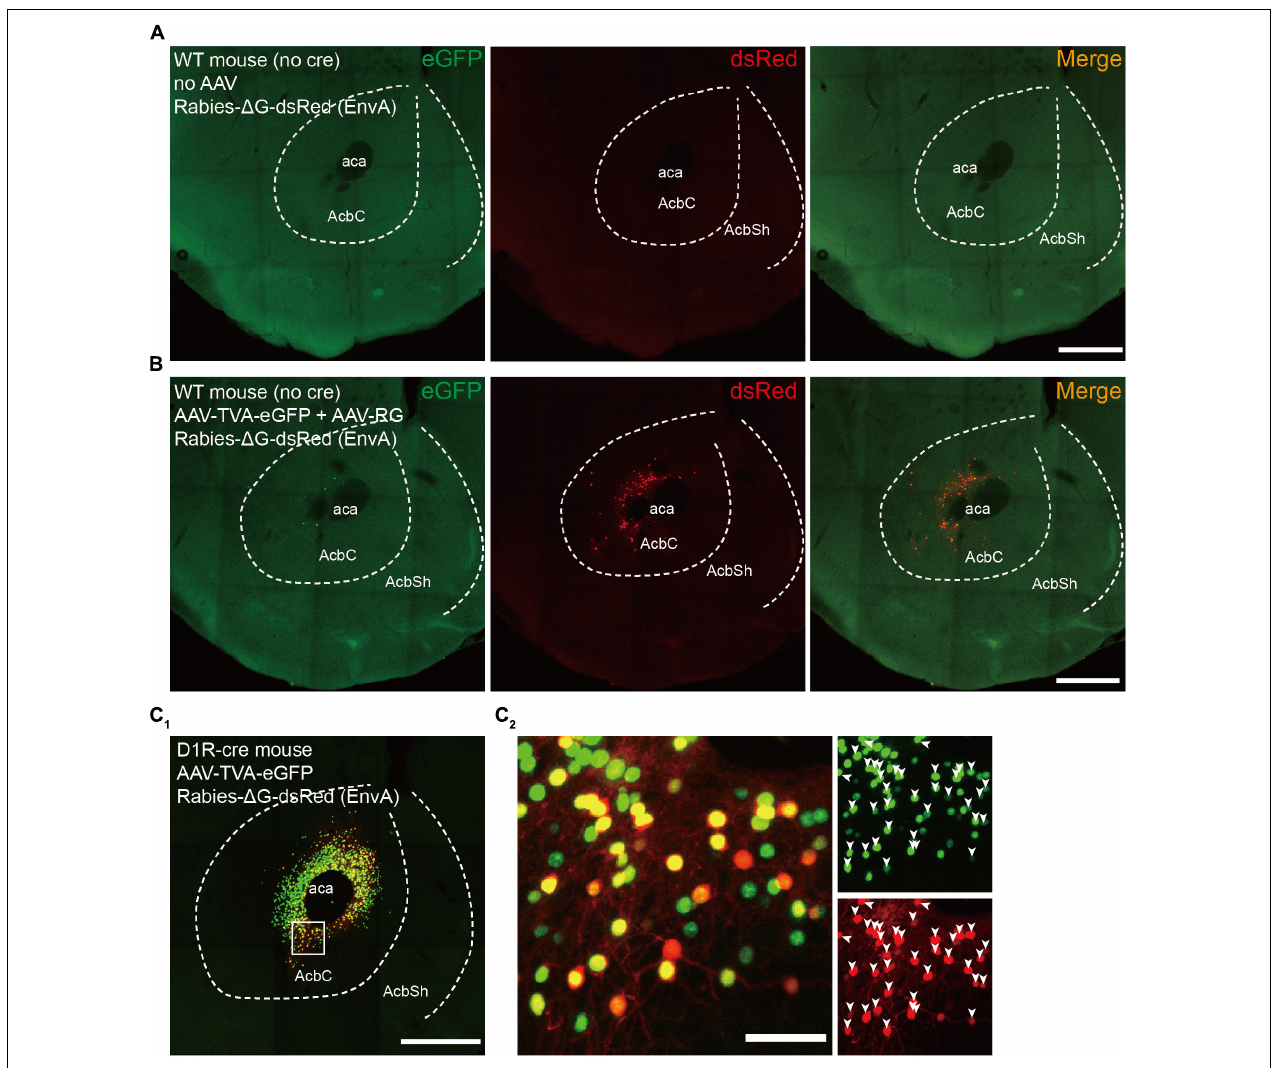
FIGURE 2 | Control experiments for rabies-mediated transsynaptic tracing. (A) Injection of RV without prior AAV injection resulted in no dsRed-labeled neurons, indicating the dependence of the RV infection on AAV-induced expression of TVA. Scale bar, 500 µ m. (B) Injecting AAV-DIO-EGFP-TVA, AAV-DIO-RG, and RV into the wild-type mice led to a low level of nonspecific labeled RV neurons that expressed dsRed at the injection site. Scale bar, 500 µ m. (C 1 ) Injection of AAV-DIO-EGFP-TVA and RV without prior AAV-DIO-RG injection in the D1R-Cre mice resulted in no DsRed-labeled input neurons. Scale bar, 500 µ m. (C 2 ) Enlarged view of the boxed region in panel (C 1 ) ; all dsRed-positive neurons coexpressed eGFP. Scale bar, 50 µ